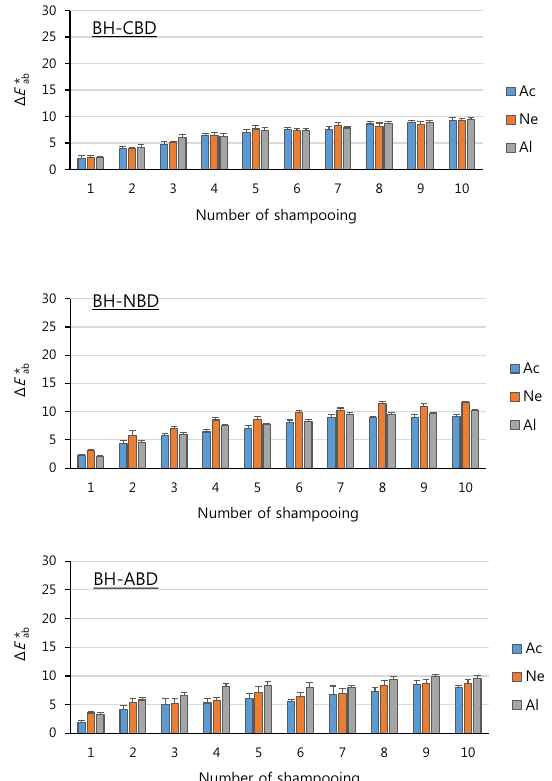
Fig. 5 Color difference (Δ E * ab ) of bleached hair (BH) dyed with three types of basic hair dye after shampooing using Acidic, Neutral, and Alkaline